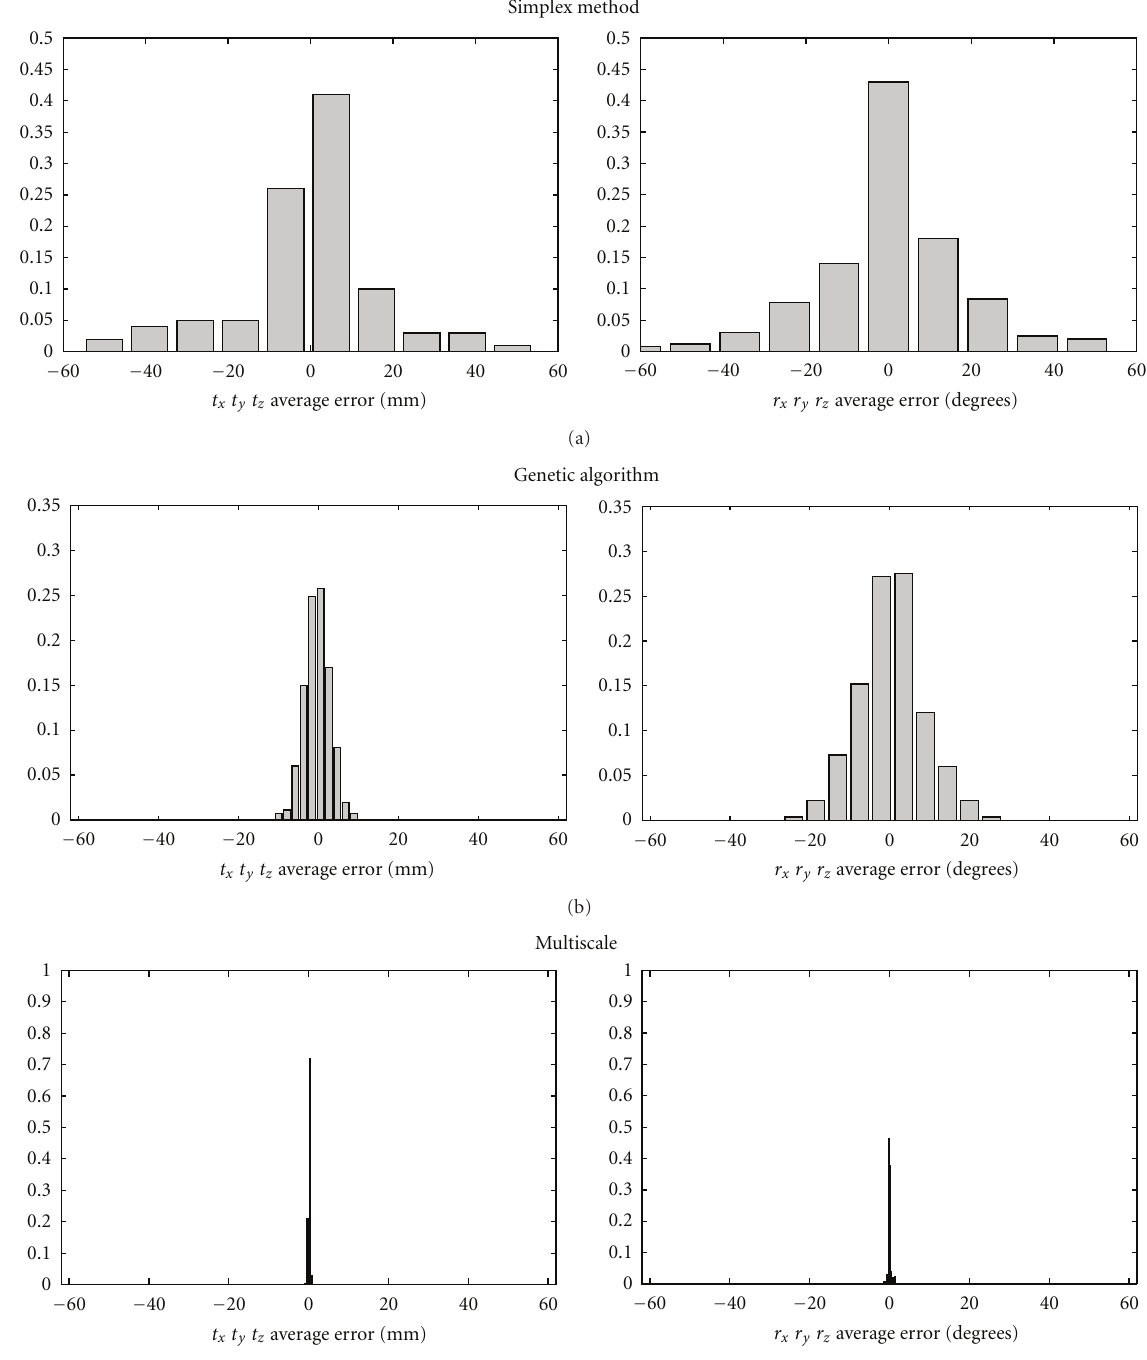
Figure 5: Accuracy of local, global and multiresolution optimization approaches when applied separately to the PET and CT cardiac models.